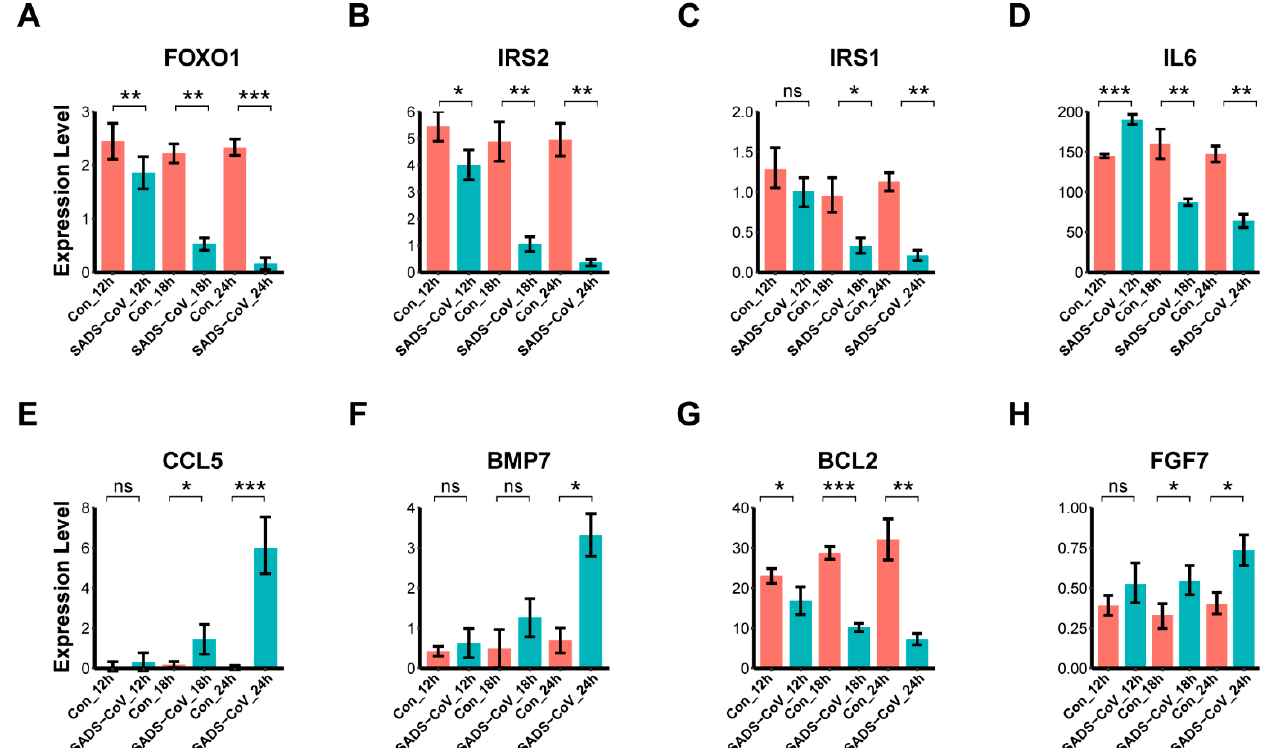
Figure 9. Quantitative real-time PCR validation of RNA-sequencing data. ( A – H ) Barplots of representative genes expression level in Vero E6 cells validated by quantitative real-time PCR, including ( A ) FOXO1, ( B ) IRS2, ( C ) IRS1, ( D ) IL6, ( E ) CCL5, ( F ) BMP7, ( G ) BCL2, ( H ) FGF7. Cultured Vero E6 cells were mock-infected or infected with SADS-CoV strain GDS04. At 12, 18, and 24 hpi, samples were harvested and relative mRNA expression levels of indicated genes were measured by quantitative real-time PCR. Data are expressed as mean ± SEM from three independent experiments. Data were analyzed using the Mann-Whitney test. ns represents not significant, p > 0.05, * represents 0.01 < p < 0.05, ** represent 0.001 < p < 0.01, *** represents p < 0.001.